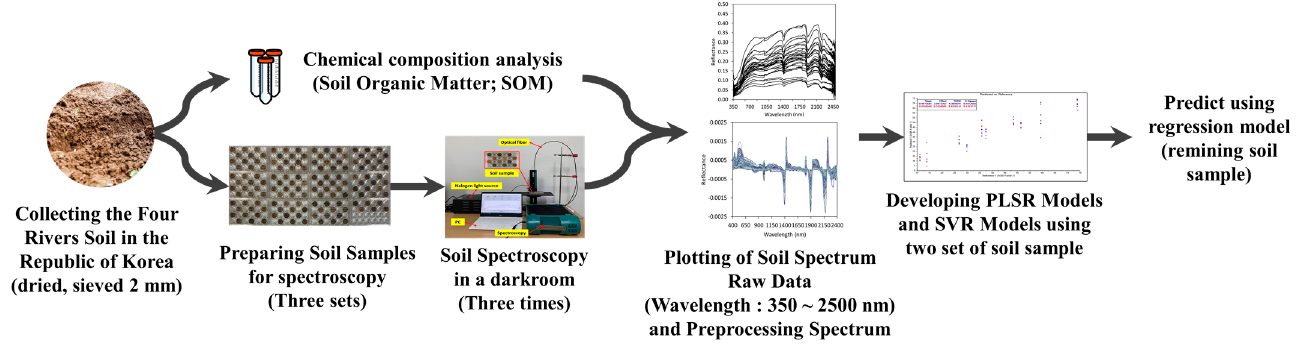
Figure 1. Experimental flowchart for developing SOM prediction models.